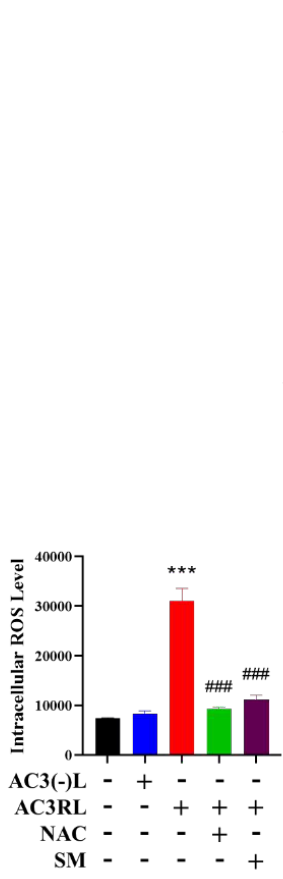
Figure 2. The reactive oxygen species (ROS) production and DNA damage effect of AC3RL in HAECs. HAECs were incubated with PBS (control, ctrl), AC3(-)L (25 µ g/mL), AC3RL (25 µ g/mL), and/or AC3RL + NAC (5 mM) or SM (sesamol, 3 µ M) for 24 h. ( A ) Intracellular ROS production in HAECs. ( B , C ) Immunofluorescence staining showing γ H2AX foci in HAECs from each treatment group. The fraction of positively stained cells is displayed as a percentage of the overall cell population. For the semi-quantitative analyses, n = 3 per group. *** p < 0.001 vs. control; ### p < 0.001 vs.